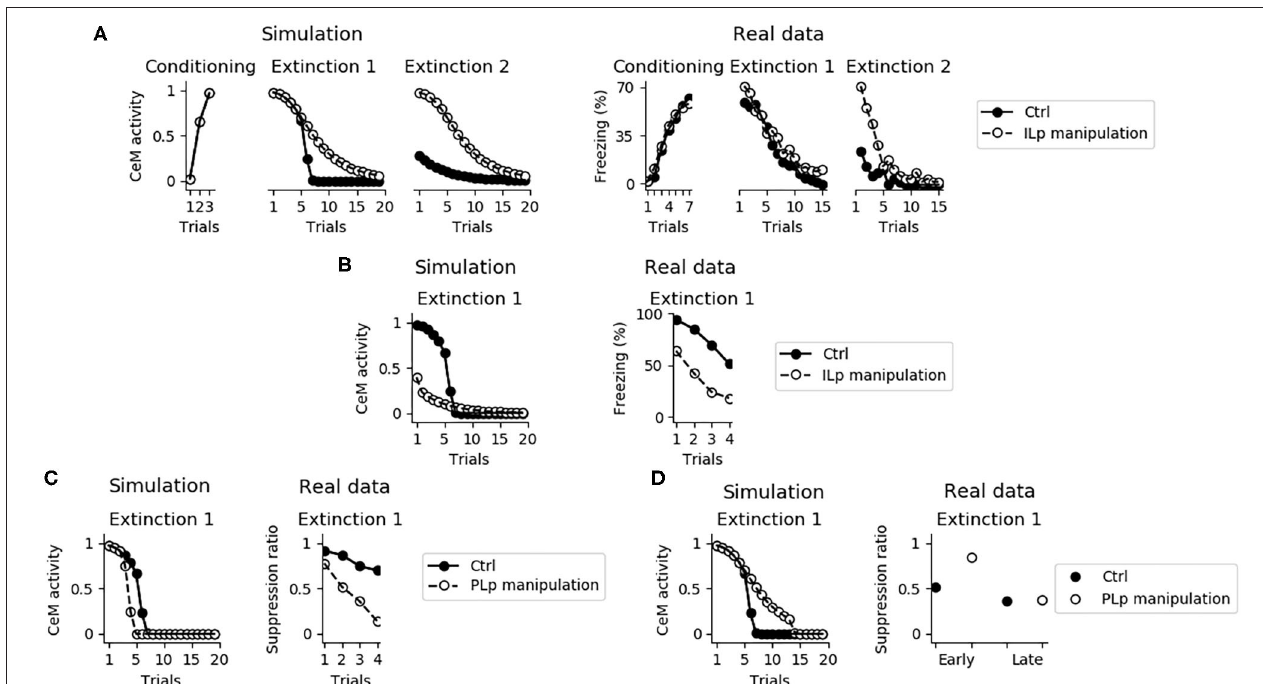
FIGURE 12 | Effects of the IL and PL manipulation on extinction. (A) The inactivation of ILp does not influence conditioning and the model shows extinction during the first session, as observed by Quirk et al. (2000). On the other hand, the model shows that the absence of a functioning IL causes a deficit in between-session extinction, as shown in Quirk et al. (2000). (B) Conversely, when the IL is stimulated extinction is faster, in accordance with data presented by Vidal-Gonzalez et al. (2006) . (C) The connection between the PL and IL controls the speed of fear extinction, as demonstrated in real data from Marek et al. (2018). In particular, if PLp-ILp connections are stimulated then fear extinction occurs earlier. (D) Instead, if PLp-ILp connections are inactivated then extinction takes